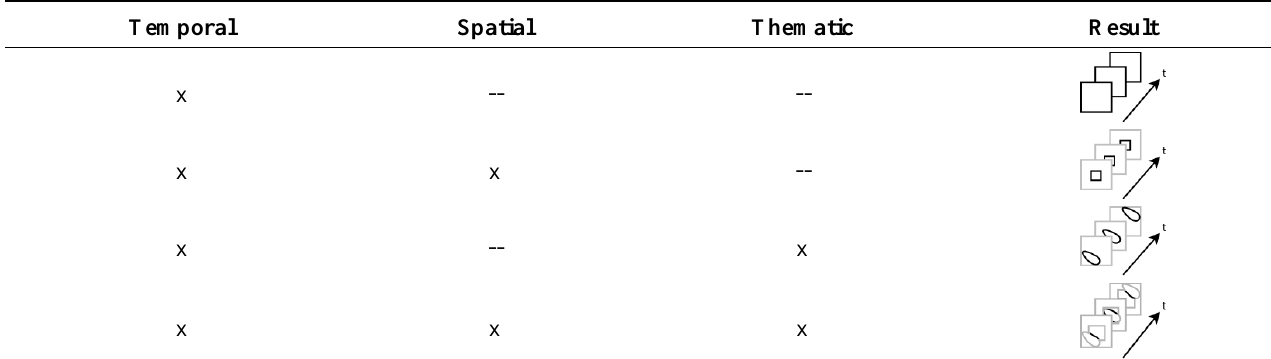
Table 1. Filter combinations and their